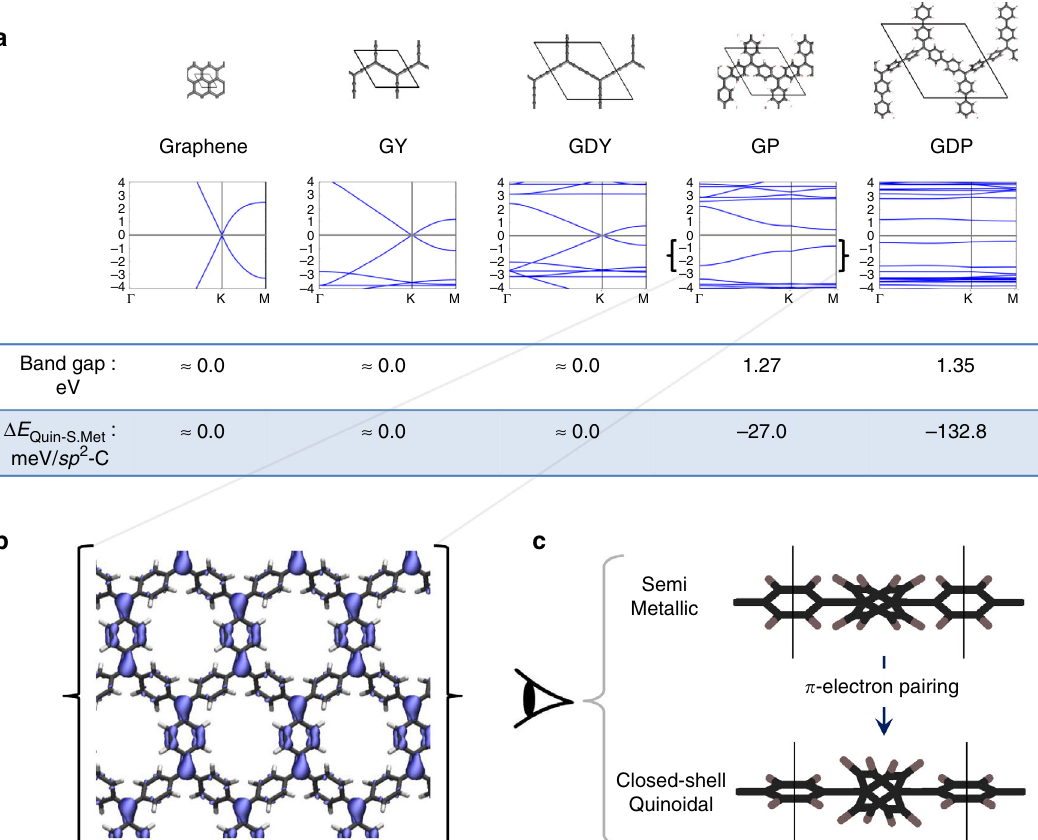
Fig. 4 Closed-shell quinoidal state. Results from restricted closed-shell PBE0 optimizations. a electronic band structures for each material. Below each band structure, we indicate the associated band gaps (eV) and the relative energies of each solution with respect to the semimetallic ones per sp 2 carbon centre ( Δ E Quin-S.Met ) in meV. b Iso-surface of the electron density corresponding to the highest occupied crystal orbital at the Γ point in GP. c x -view of the GP structure in the semimetallic and closed-shell quinoidal solutions, where the planarization of certain phenyl rings upon electron pairing can be